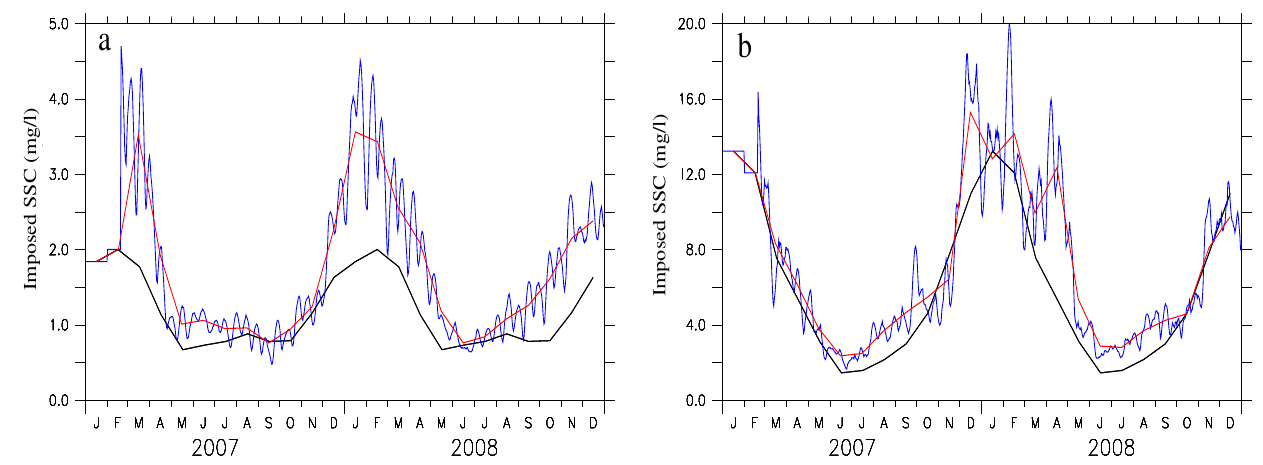
Figure 4. Time series of imposed near-surface SSC in Configurations (black line) B, (blue line) C and (red line) D averaged along the ( a ) western and ( b ) northern boundaries of the outer computational